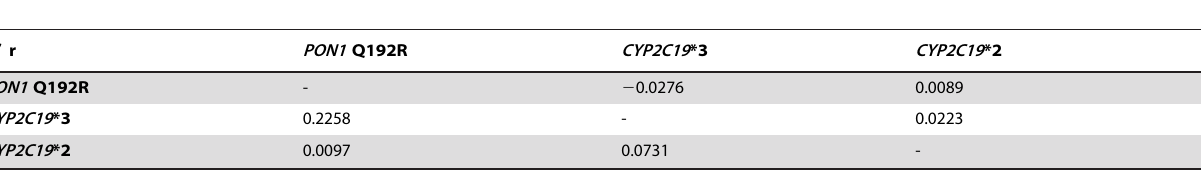
D 9 values are shown in the lower triangle, and r values are shown in the upper triangle.